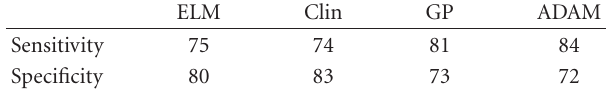
Table 3: ELM: Epiluminescence diagnosis (Dermatologists); Clin: Clinical diagnosis (Dermatologists); GP: Clinical diagnosis by General Practitioners; ADAM: our system. ELM Clin GP ADAM